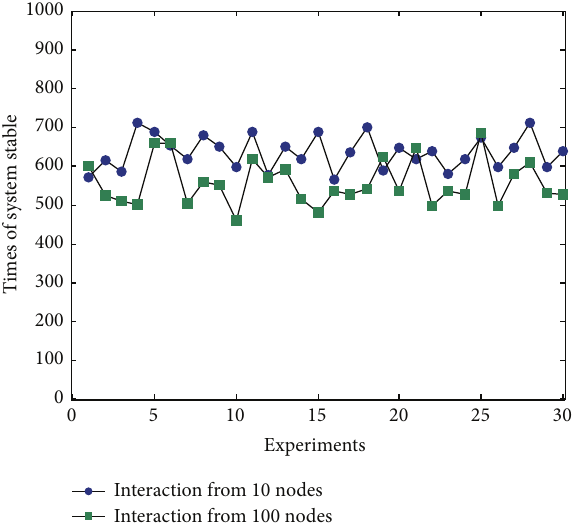
Figure 9: Times of system stable under 30 random experiments for interaction from 10 nodes and 100 nodes, respectively.